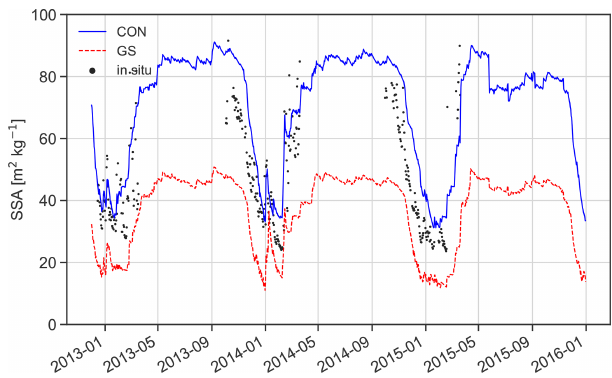
Figure 5. Time series of average SSA for Dome C of the upper 2cm of the snowpack in CON and GS and as observed by Picard et al.